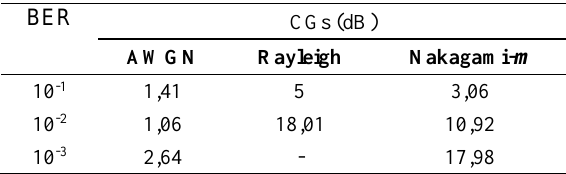
Table 1. CGs for WH/LDPC codes